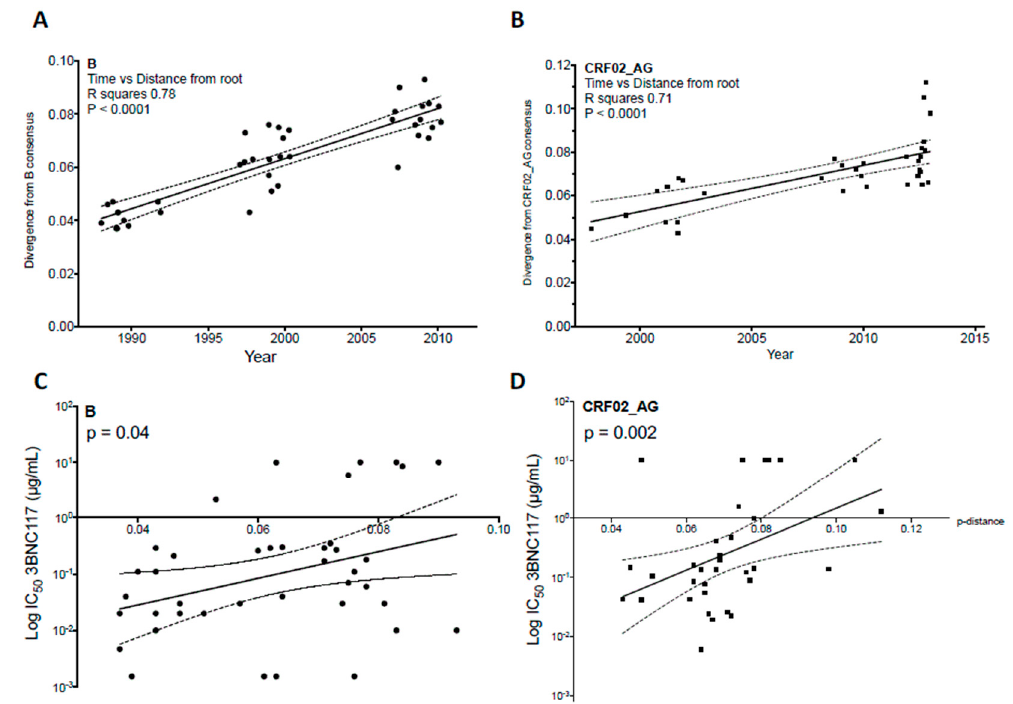
Figure 4. The diversification of HIV-1 over the course of the epidemic is associated with increased resistance to bnAbs. Panels ( A – D ) illustrate this phenomenon for two subtypes, by studying T / F viruses sampled shortly after seroconversion in HIV-1 infected individuals from 1987 to 2012 in France [61,62,73]. ( A , B ) The genetic distance of subtype B ( A ) and CRF02_AG ( B ) T / F variants from a consensus B or CRF02_AG, respectively, correlates with calendar year and increases over time. Sequences were codon-aligned with CRF02_AG consensus sequence (Los Alamos database). After exclusion of hypervariable regions, evolutionary divergence was estimated by distance matrix using MEGA software. Pearson correlation. ( C , D ) IC 50 values of 3BNC117 were positively correlated with distance, indicating an increase in resistance. Spearman correlation.